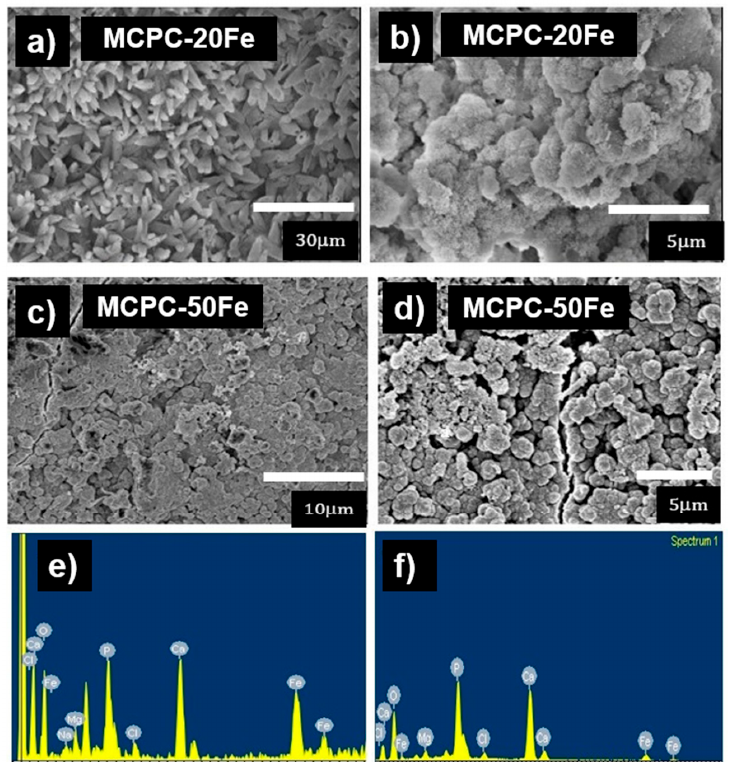
Figure 3. SEM images and EDS spectrum of MCPC with different concentrations of magnetite after a seven-day immersion in Simulated Body Fluid (SBF). ( a ) Low magnification micrographs of MCPC-20Fe show the formation of elongated petal-like apatite crystals. ( b ) High magnification of ( a ) shows the globular structure and the nanoflake-like nature of the apatite particles. ( c ) Low magnification micrographs of MCPC-50Fe indicate the formation of a dense layer of apatite, totally covering the cement surface. ( d ) High magnification of ( c ) reveals the globular structures of apatite. ( e ) EDS signals of MCPC-20Fe. ( f ) EDS signals of MCPC-50Fe. MCPC indicates magnetic calcium phosphate cement, and Fe indicates magnetite incorporation.